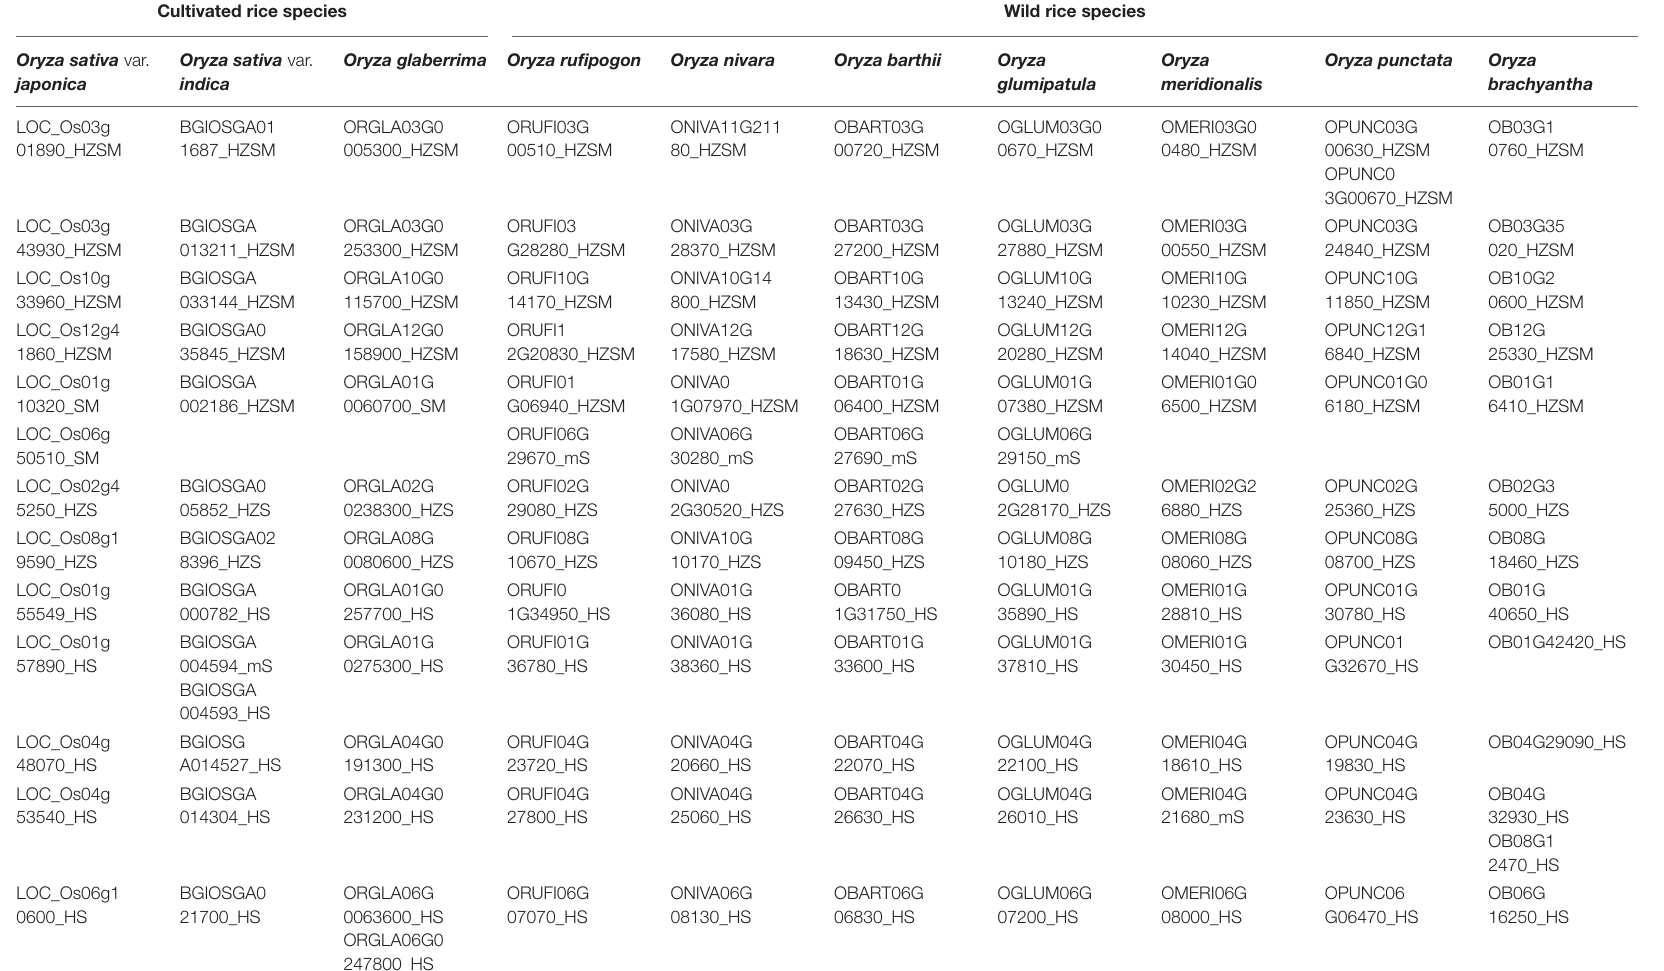
TABLE 3 | START genes in Oryza sativa var. japonica and their best orthologs amongst other nine rice species. Cultivated rice